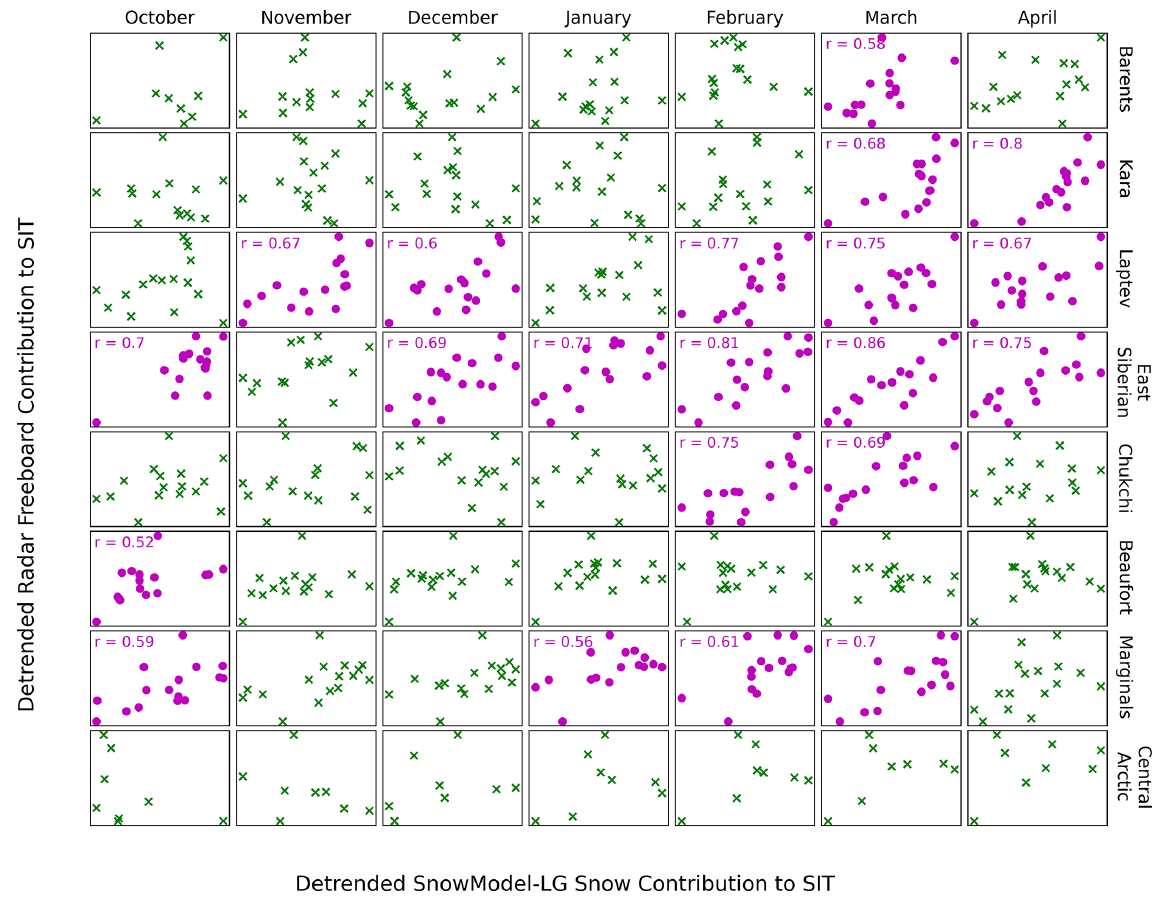
Figure 7. Covariability of contributions to sea ice thickness from radar freeboard and SnowModel-LG-derived snow components over all sea ice types. Plots are coloured with magenta when a statistically significant correlation is present between the contributions ( p > 0 . 95). Analogous plots are displayed for the FYI and MYI components of the regions in Figs. S9 and